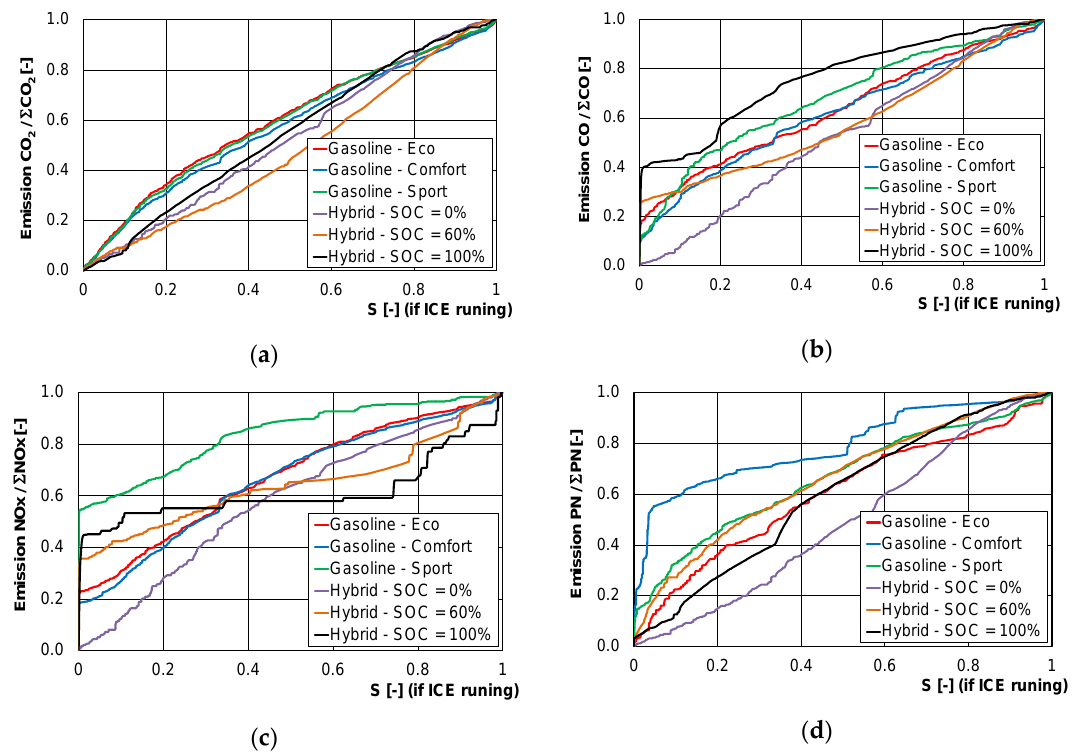
Figure 9. Relations of the rate of increment of the mass of the exhaust components depending on the covered distance: ( a ) carbon dioxide, ( b ) carbon monoxide, ( c ) nitrogen oxides, and ( d ) particle number.